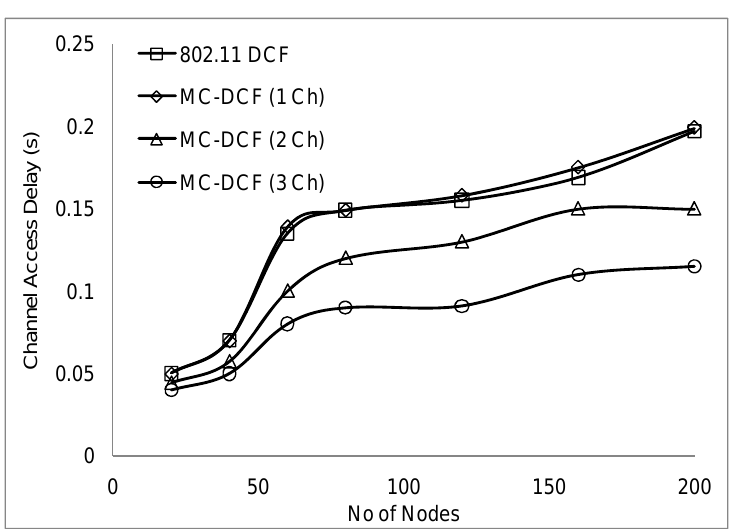
Figure 12. Delay impact on node density.